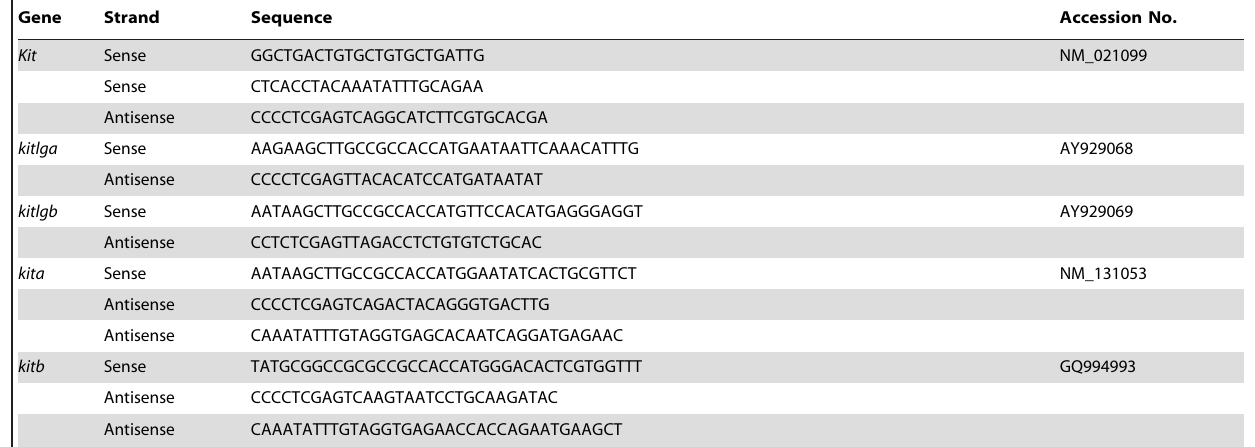
Table 1. Primers used in RT-PCR.